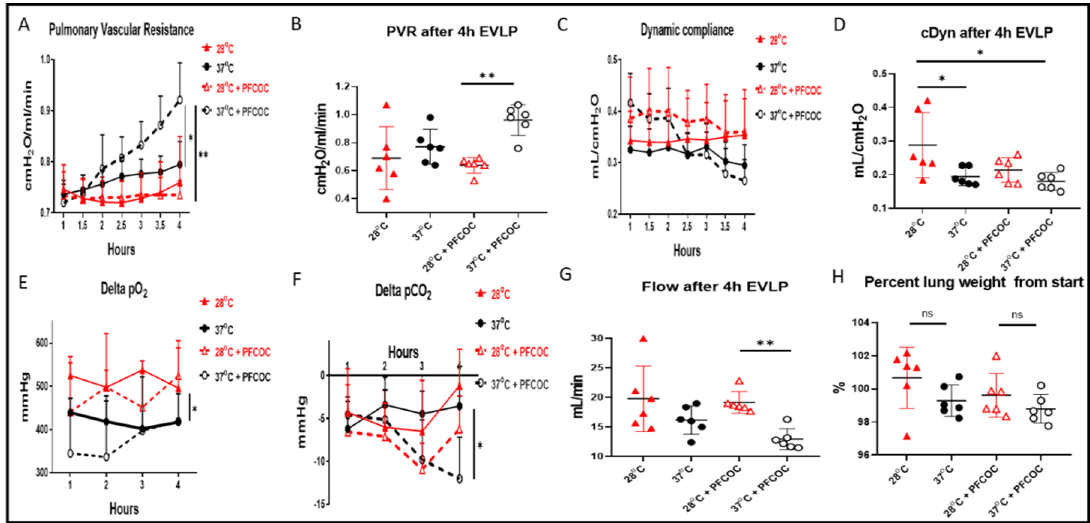
Figure 1. Lung oxygen and carbon dioxide exchange function, PVR, Cdyn and flow during EVLP. ( A ). PVR values during EVLP at 37 ◦ C +/ − PFCOC were higher than the subnormothermic conditions but only significantly higher when compared to EVLP at 28 ◦ C with PFCOC (* p < 0.05, ** p < 0.01). During the 5 min end of EVLP stress test, ( B ) the PVR in the 28 ◦ C + PFCOC EVLP was significantly reduced (** p < 0.01) but the similar variations observed at 28 ◦ C without PFCOC were not significant when compared to EVLP at 37 ◦ C without PFCOC. ( C ). Cdyn values during EVLP at 28 ◦ C +/ − PFCOC were higher but not significantly higher than the EVLP at 37 ◦ C +/ − PFCOC. During the 5 min end of EVLP stress test, ( D ) the Cdyn of the 28 ◦ C without PFCOC was significantly higher than the 37 ◦ C temperature (* p < 0.05). ( E ). During EVLP at 28 ◦ C +/ − PFCOC, the lung oxygen exchange function was higher when compared to the 37 ◦ C +/ − PFCOC conditions (* p < 0.05). ( F ). During EVLP at 37 ◦ C + PFCOC condition the lung carbon dioxide exchange function were significantly higher as compared to the 37 ◦ C without PFCOC condition (* p < 0.05). ( G ). During the 5 min end of EVLP stress test, in the 28 ◦ C + PFCOC EVLP, the flow was significantly higher (** p < 0.01) compared to EVLP at 37 ◦ C with PFCOC. ( H ). The lungs gained weight after EVLP at 28 ◦ C +/ − PFCOC but weight gains were not significantly higher when compared to the 37 ◦ C +/ − PFCOC